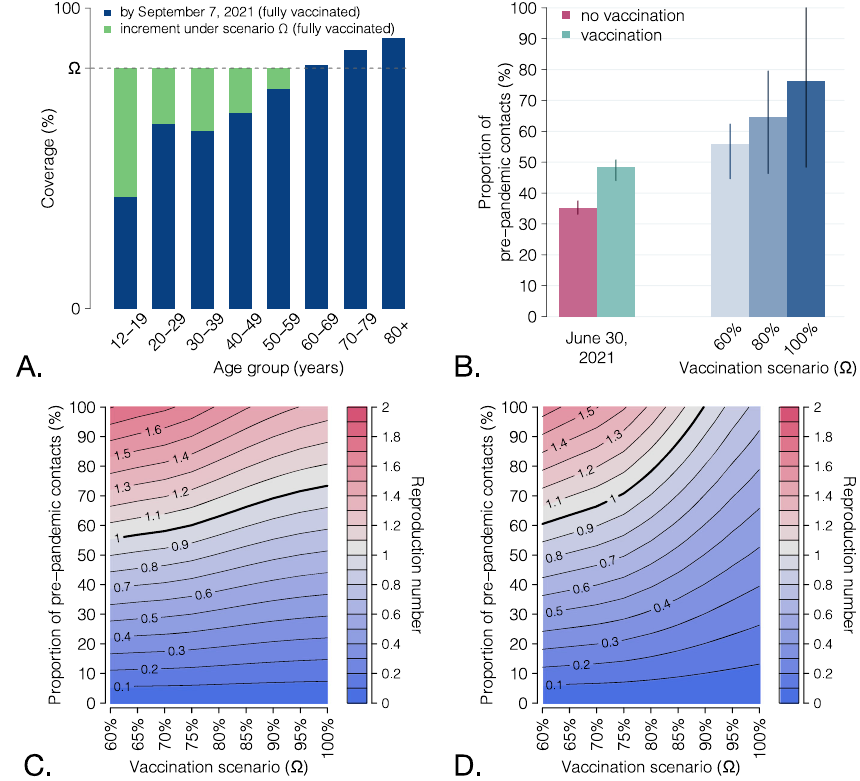
Fig. 4 Scenarios for the expansion of vaccination coverage. A Schematic of simulated scenarios. All age classes with coverage below a given value Ω are assumed to progress to Ω ; all age classes above Ω will remain at the coverage level achieved on Sep 7. B Proportion of pre-pandemic contacts corresponding to a reproduction number of 1 for three selected vaccination scenarios; levels estimated to be active on June 30, 2021 (with and without vaccination) are reported for comparison. Bars: mean estimates; vertical lines: 95% CI; n = 300 stochastic model realizations. C Heatmap of the mean estimated reproduction number for different vaccination scenarios (x axis) and different levels of social activity (y axis); n = 300 stochastic model realizations. Contour lines discriminate different values of the reproduction number. The thicker contour line represents the epidemic threshold of 1. D As C , but assuming that coverage Ω is achieved also in pediatric age groups (5 – 11